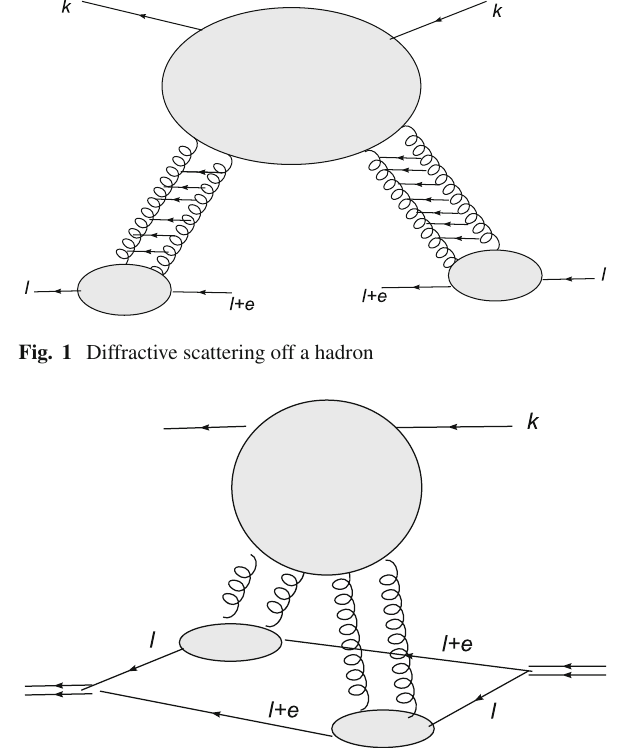
Fig. 2 Doublescatteringonthedeuteronornucleus.Inthesecondcase the spectator nucleons are not shown